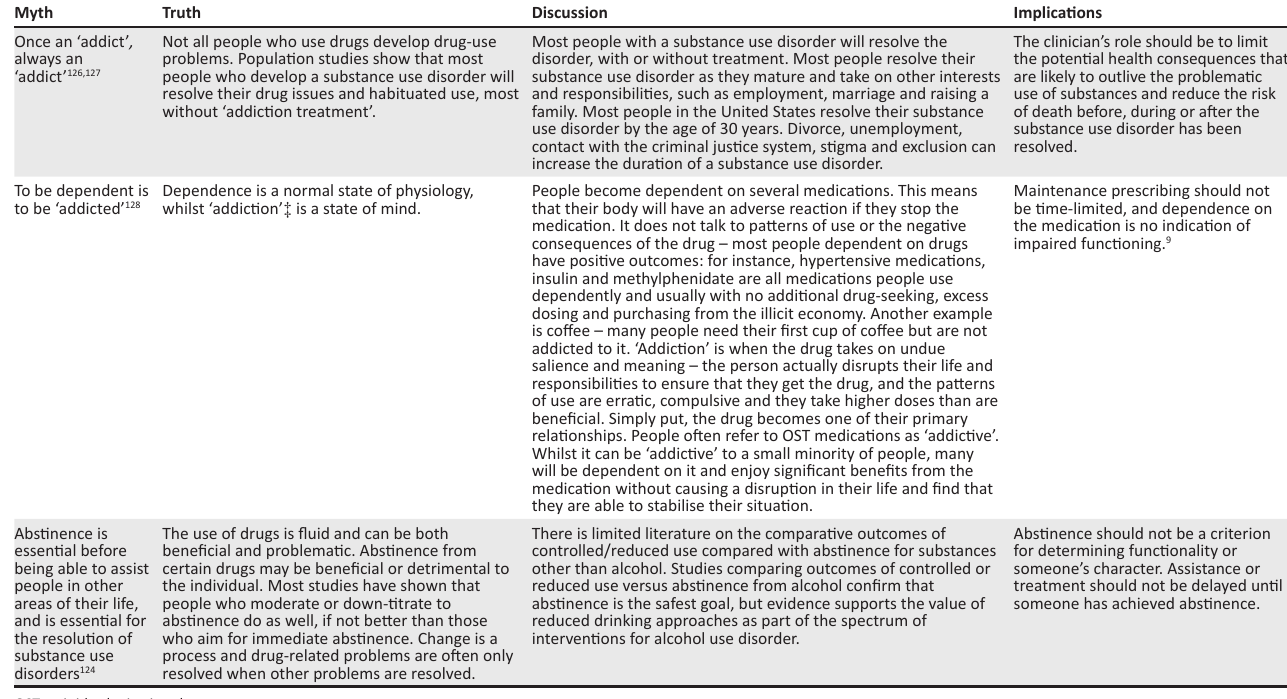
TABLE 1-A1: Common myths about drug use. †